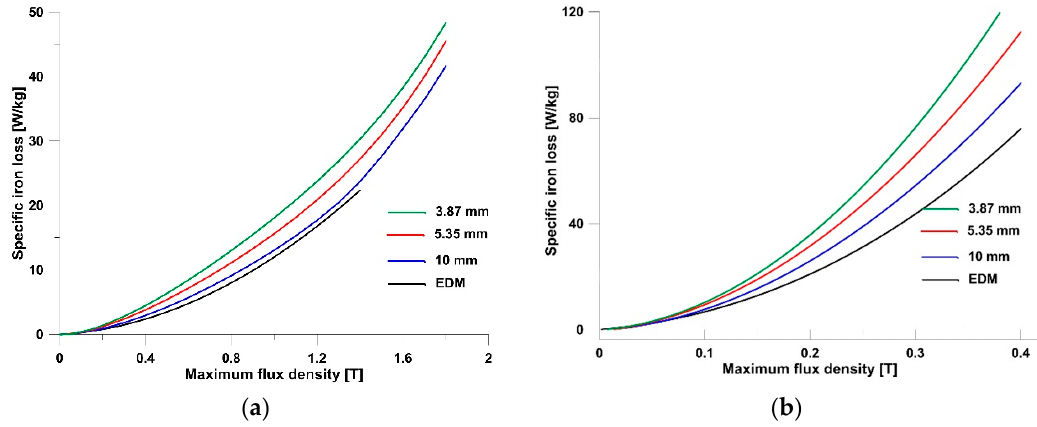
Figure 5. The comparison of specific iron loss, for various strip widths, for 200 Hz ( a ), and for 2000 Hz ( b ).